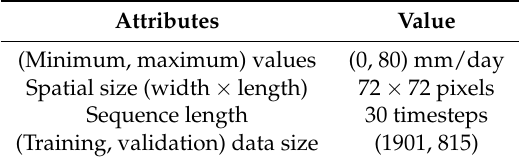
Table 2. Details of CPC Merged Analysis of Precipitation (CMAP) data.